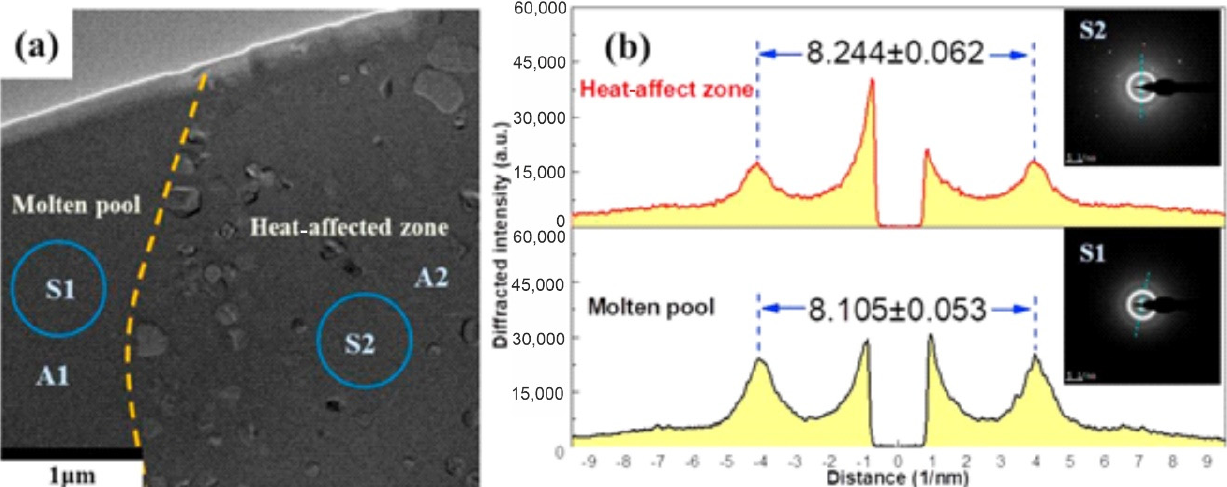
Figure 31. ( a ) Bright-field TEM image of the melt pool boundary of a Zr-based BMG fabricated via LPBF and ( b ) diffraction intensity distribution based on the SAED of S1 and S2 in ( a ). Reproduced from [40], with permission from Elsevier, 2021.